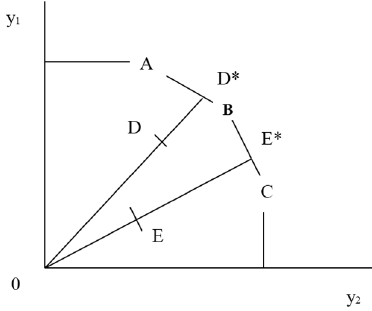
Figure 1. Output oriented data envelop analysis. Farms A, B and C are efficient and therefore define the production frontier for this group of five farms. On the other hand, countries D and E are inefficient as their output is below the optimum as defined by the production frontier. The technical efficiency score for farm D p TED q and E p TEE q are as defined below: TED “ OD { OD ˚ and TEE “ OE { E ; ˚ with A and B and B and C as their peers, respectively, which means that D and E are benchmarked against A and B and B and C, respectively.